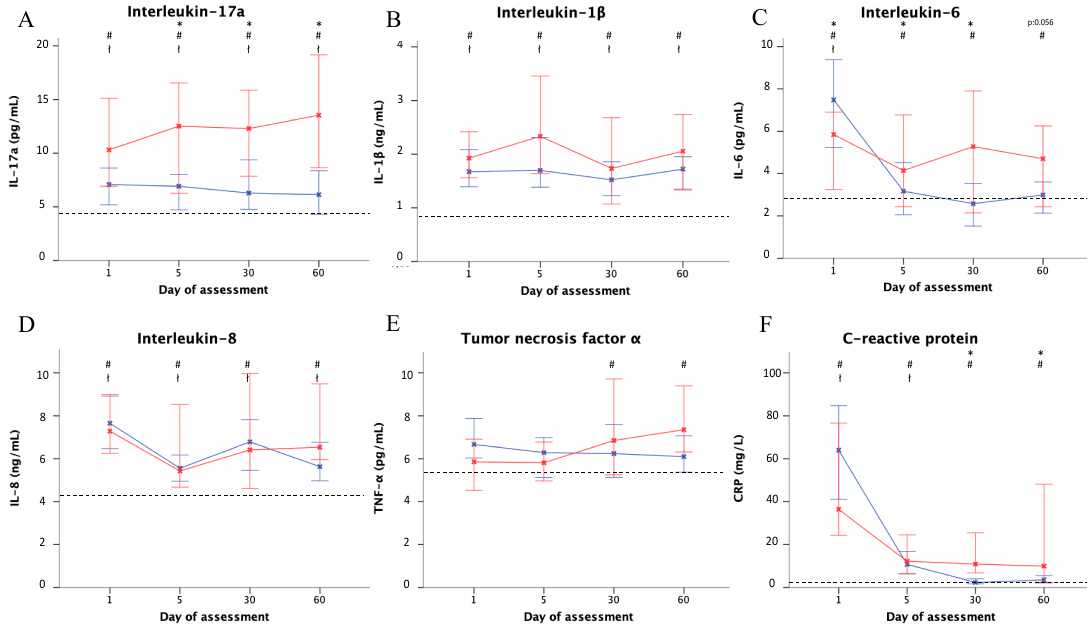
Figure 2. Inflammatory cytokine and hsCRP levels by PA isolation and day of assessment. Data are shown for patients with (red) and without (blue) PA isolation by day of assessment (days 1, 5, 30, and 60): ( A ) IL-17a; ( B ) IL-1 β ; ( C ) IL-6; ( D ) IL-8; ( E ) TNF- α ; ( F ) hsCRP. The dashed line shows the median in control (stable) patients. Blades represent the median and error bars represent 95% Confidence Intervals. * p < 0.05 (PA vs. non-PA), # p < 0.05 (PA vs. controls), ł p < 0.05 (non-PA vs. controls). Abbreviations: hsCRP, high-sensitivity C-reactive protein; IL, Interleukin; PA, Pseudomonas aeruginosa ; TNF- α , Tumor necrosis factor